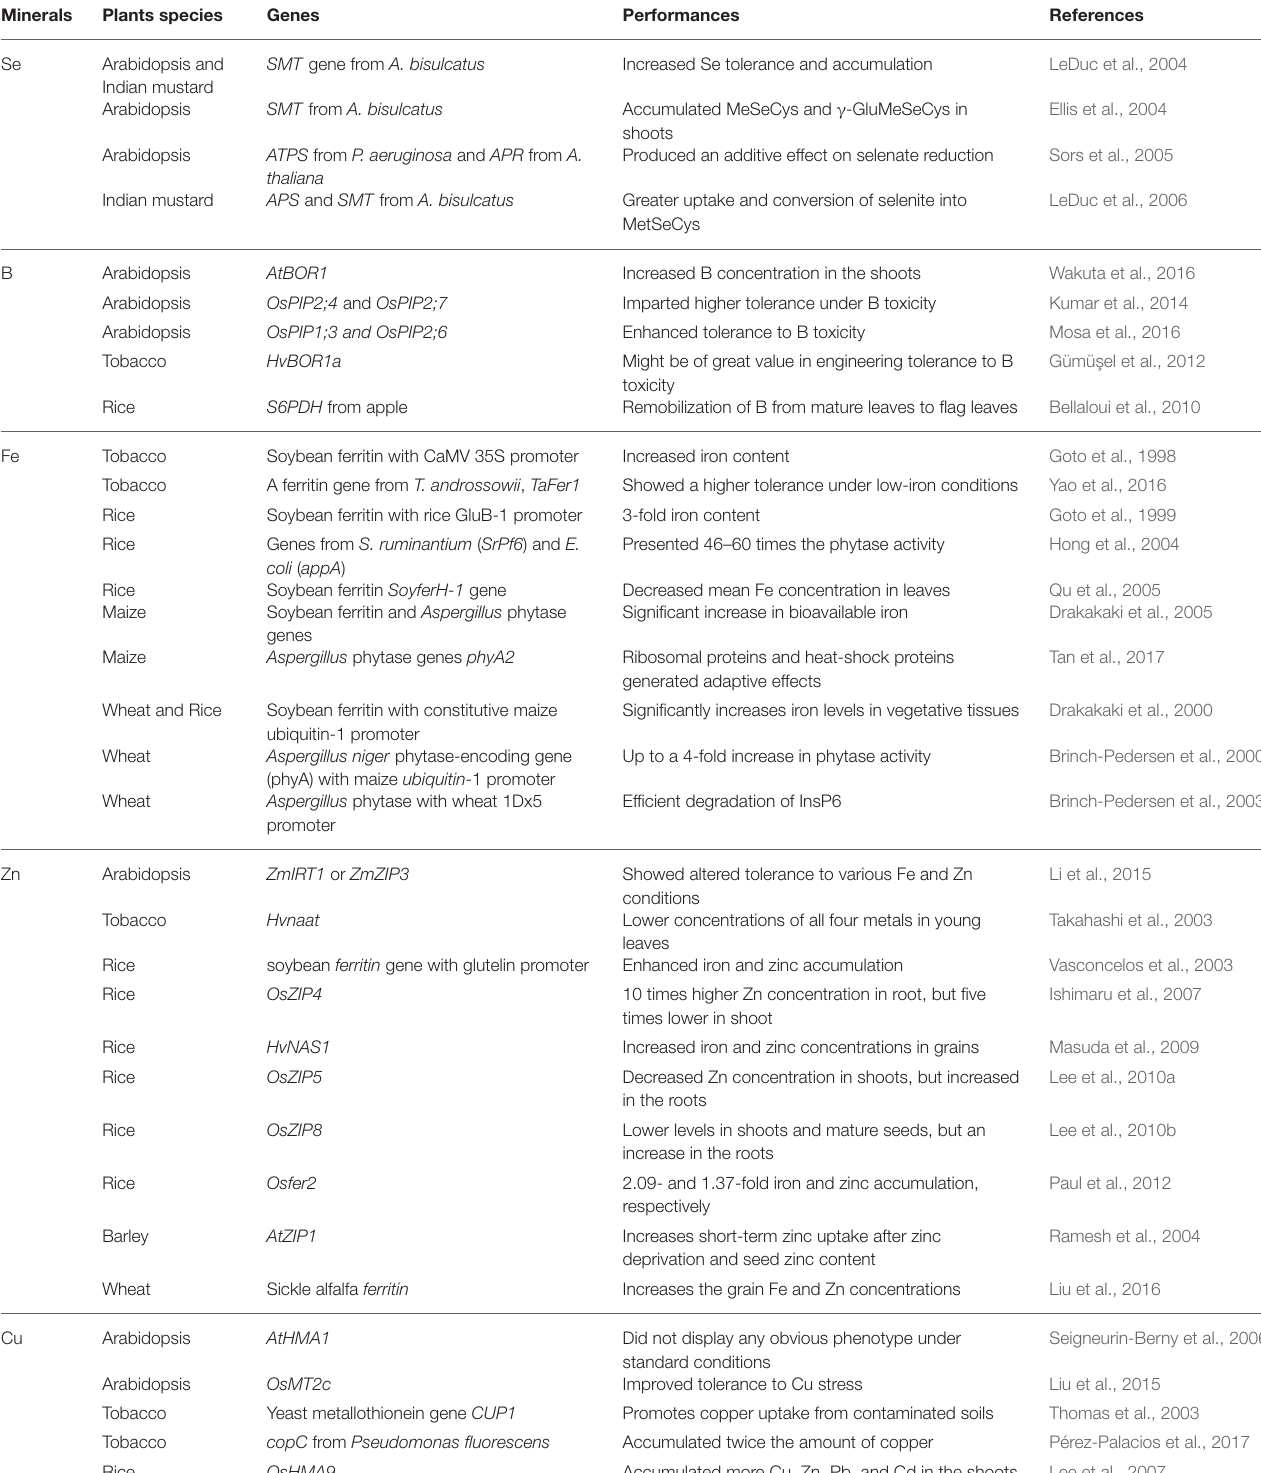
TABLE 1 | Summary of minerals and transformation of certain genes.